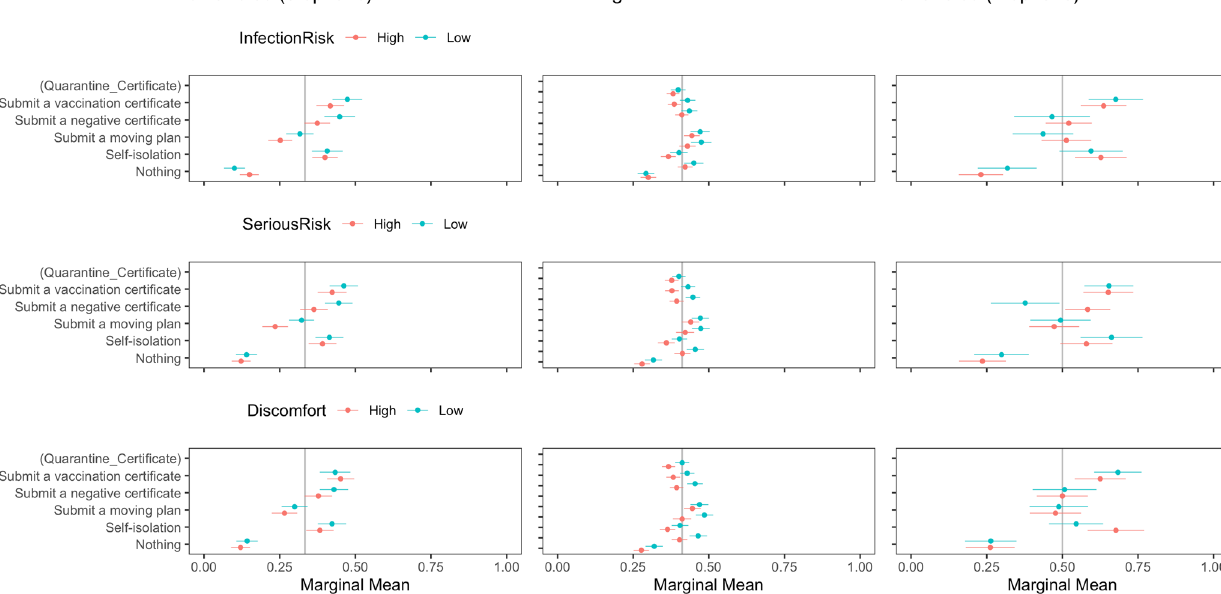
Fig. 4 Marginal means of the probability or rating for travelers ’ entry conditioned by risk perceptions of COVID-19 with error bars of 95% con fi dence intervals. The vertical lines show the random probability (0.33) for Panel a using the choice-based question (three options including “ Neither should be admitted ” ), the mean (0.41) for Panel b using the rating-based question, and the random probability (0.5) for Panel c using the choice-based question (two